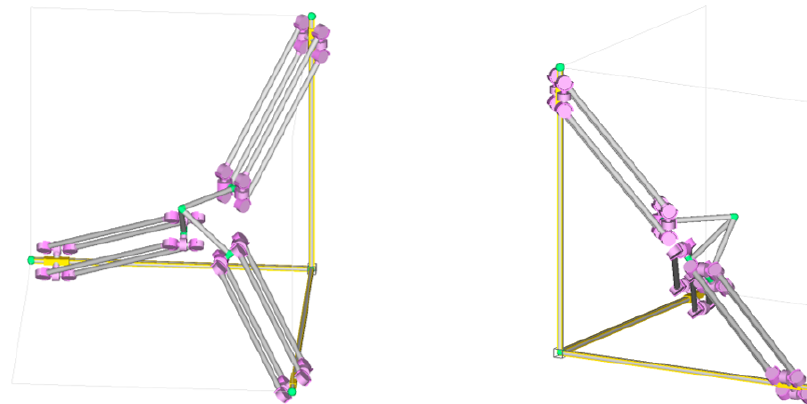
Figure 11. Singular posture. All legs parallel to a plane (two different